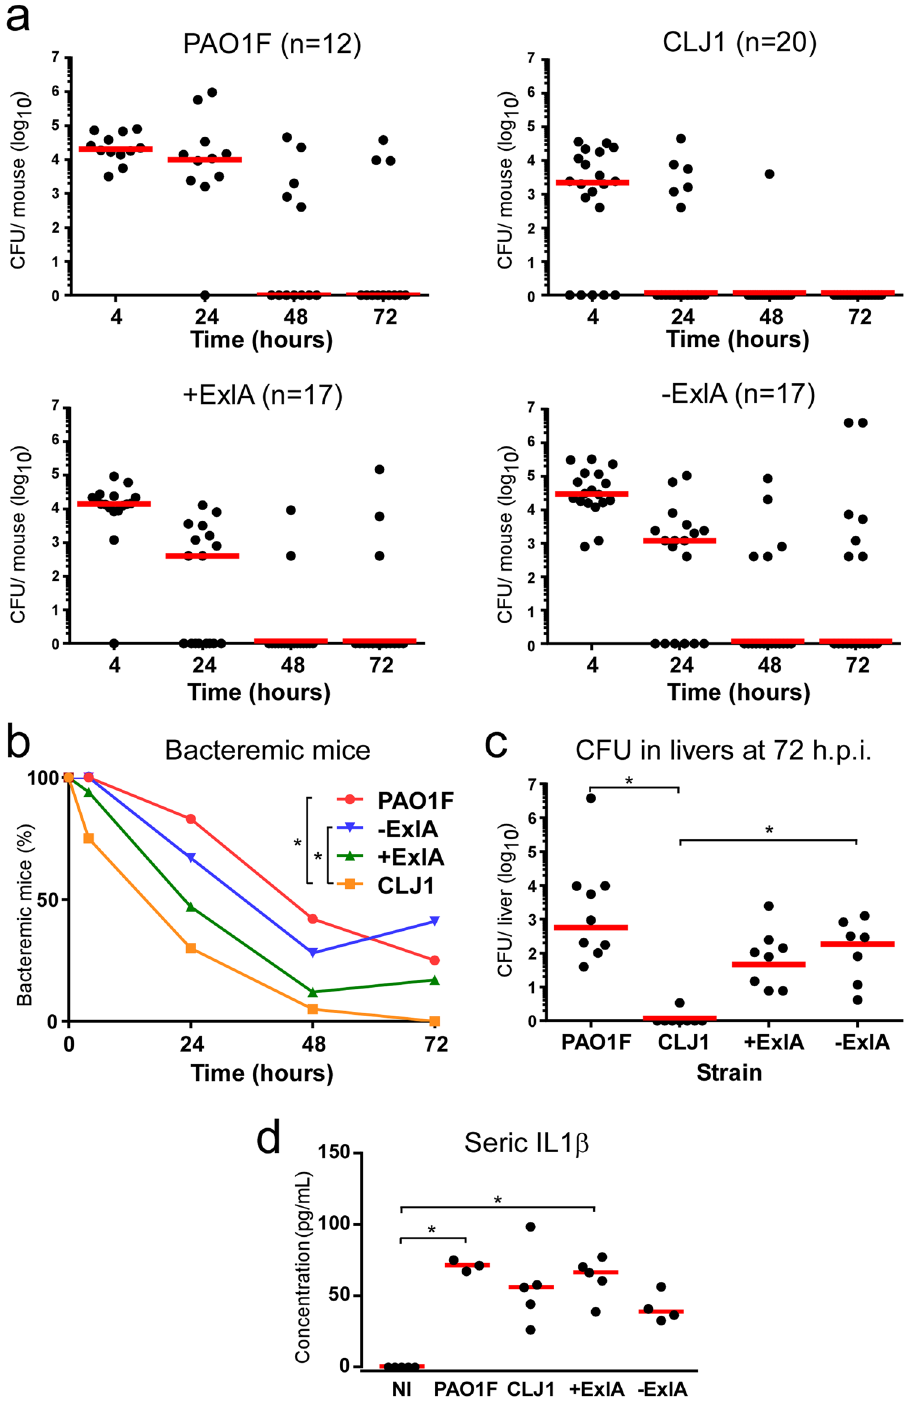
Figure 4. Bacterial survival in blood and liver colonisation in a bacteremic model. Bacteria (1 × 10 7 ) from CLJ1, PAO1F, PAO1F Δ T3SS::exlBA ( + ExlA), PAO1F Δ T3SS::vector ( − ExlA) strains were injected in mouse caudal veins (mouse numbers are shown after strain names). ( a ) CFU were counted at different time points (4, 24, 48 and 72 h.p.i.) in blood samples and data for each mouse are represented by solid circles for the entire blood compartment. Medians are shown by red bars. ( b ) Percentages of bacteremic mice during time. Statistics: Friedman’s test, p = 0.003; Holm-Sidak’s post-hoc test, * p < 0.05. ( c ) CFU calculated for the entire livers at 72 h.p.i. Statistics: Kruskal-Wallis’s test, p < 0.001; Dunn’s post-hoc test, * p < 0.05. ( d ) Seric levels of IL-1 β . Statistics: Kruskal-Wallis’s test, p < 0.004; Dunn’s post-hoc test, * p <